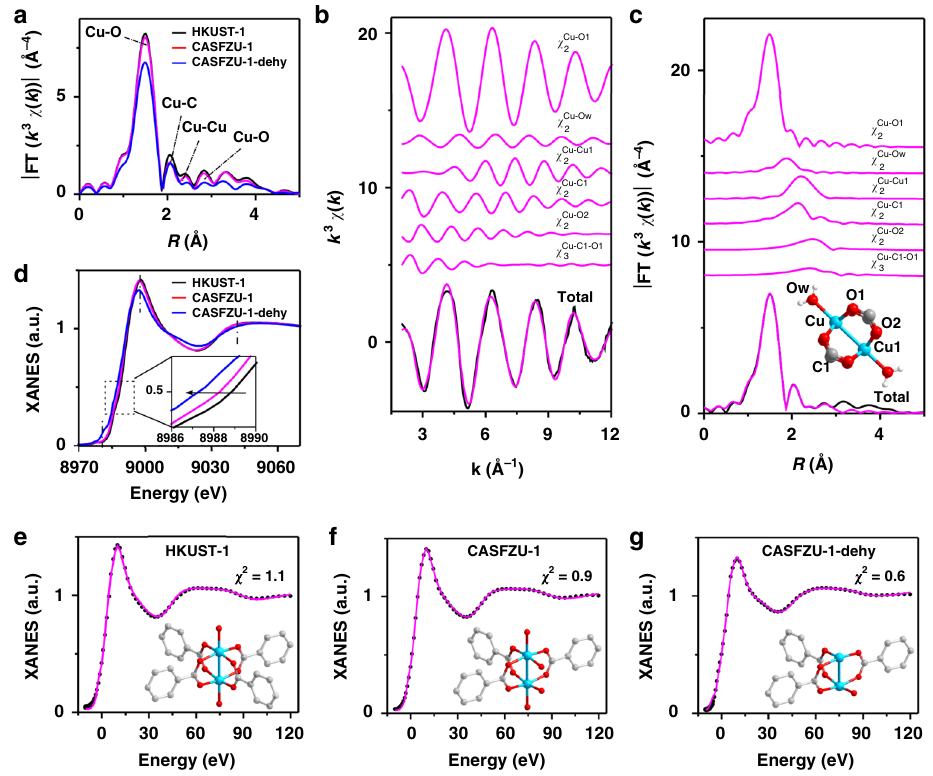
Fig. 3 Structural characterisation by EXAFS and XANES spectroscopy. a Fourier transformed magnitudes of the experimental K-edge EXAFS signals for HKUST-1 and CASFZU-1 samples before and after dehydration (denoted as CASFZU-1-dehy). The Fourier transforms are not corrected for phase shift. The origin assignment for the EXAFS peaks is given in Supplementary Figure 26. b , c Cu K-edge EXAFS analysis of CASFZU-1 after dehydration in k and R spaces, respectively. Curves from top to bottom are the single backscattering signal χ 2 and double scattering signal χ 3 included in the fi t, and the total signal (red line) superimposed on the experimental signal (black line). The inset shows the structure of the hydrated [Cu 2 C 4 O 8 ](H 2 O) 2 moiety used for simulation of the EXAFS signals. d The experimental Cu K-edge XANES spectra. e – g Comparison between the experimental XANES spectra (black dotted lines) and the best- fi t theoretical spectra with the depicted structural models (solid red lines). e The hydrated [Cu 2 C 4 O 8 ](H 2 O) 2 cage. f The defective three-coordinated [Cu 2 C 3 O 6 ](H 2 O) 3 OH cage. g The dehydrated three-coordinated [Cu 2 C 3 O 6 ]OH paddlewheel model, where one of the two coordinatively unsaturated Cu atoms is directly bound by one hydroxide anion, OH − . Colour scheme for chemical representation: cyan, Cu; red, O;